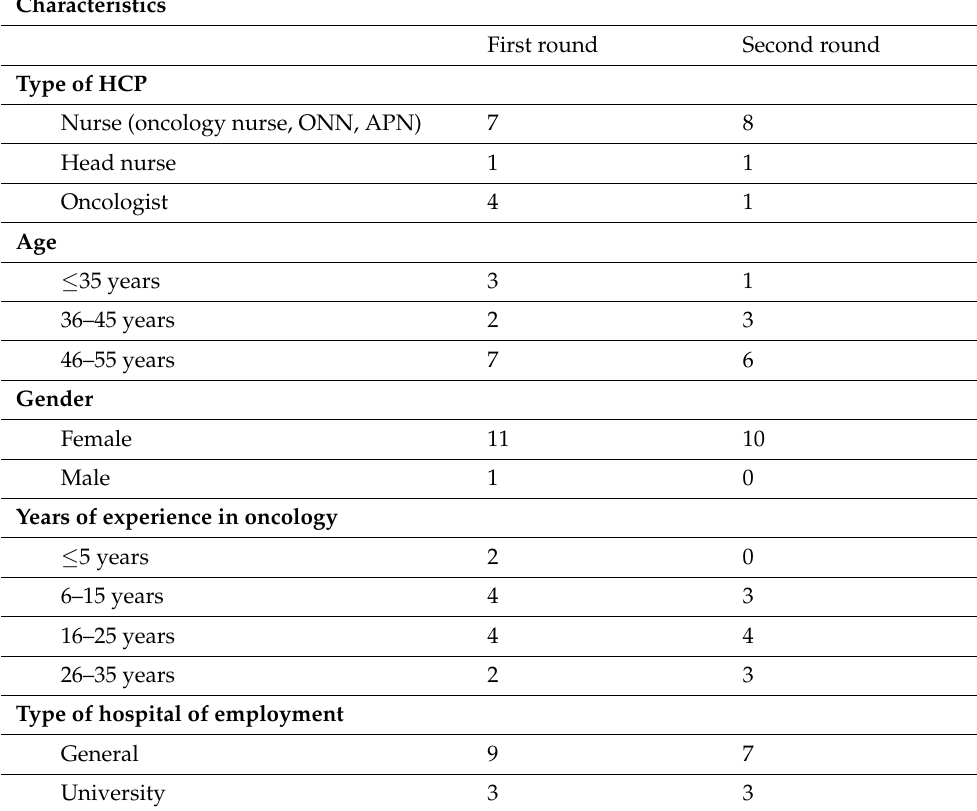
Table 1. Characteristics of included healthcare